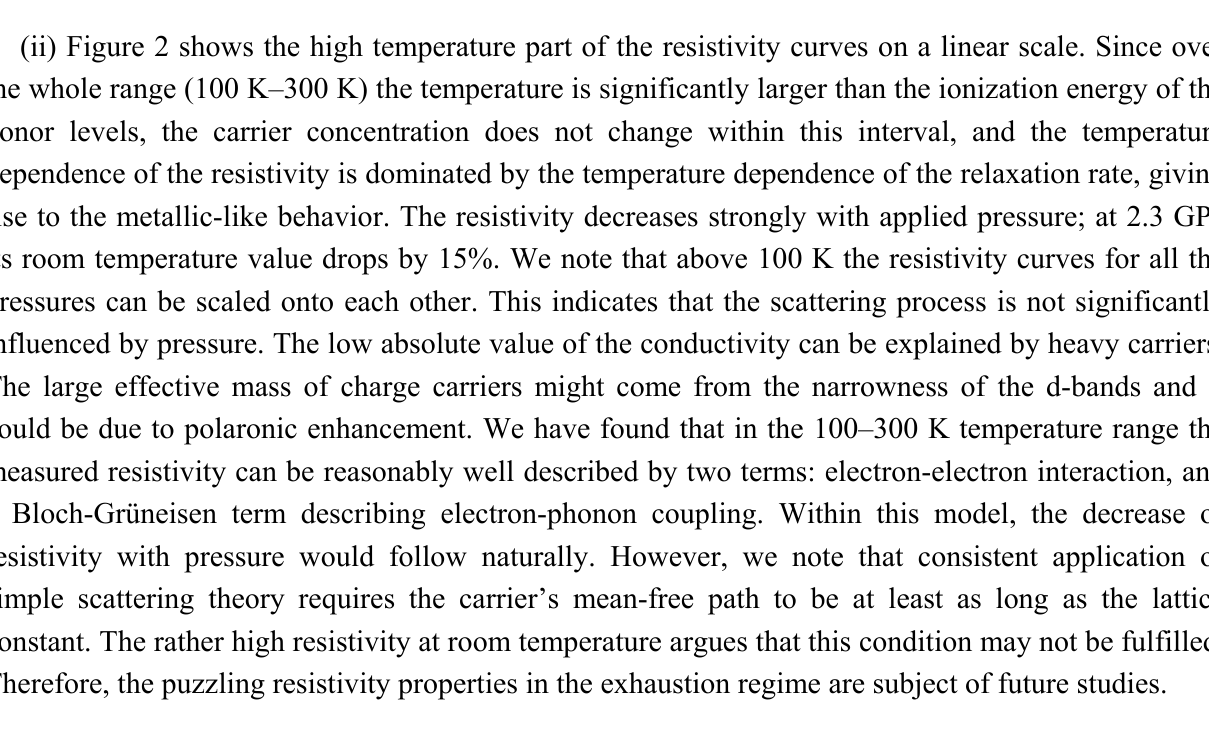
Figure 2. The temperature dependence of the resistivity in the exhaustion regime (above 100 K) at various